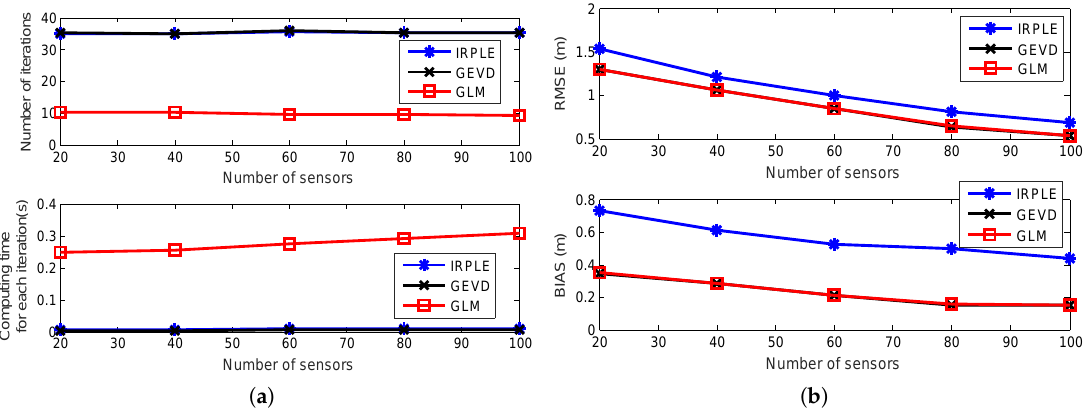
Figure 11. Scalability analysis for various number of sensors. ( a ) Number of iterations and computing time. ( b ) RMSE and bias performance.